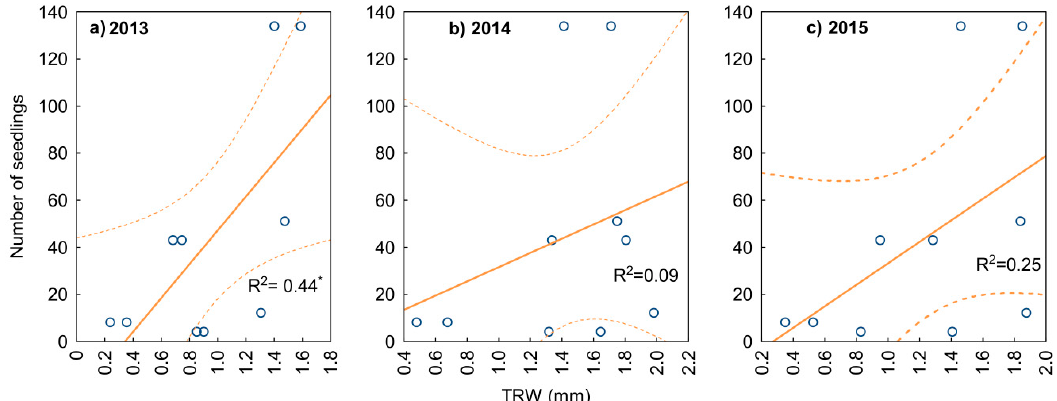
Figure 4. Relationship between density of yew seedlings and radial increment of mother trees in ( a ) the year prior to seed formation; ( b ) the year of seed formation; and ( c ) the year after seed formation. At the stand level, a significant increase in the tree-ring width of yews was observed after the beginning of stand regeneration via shelterwood cutting in 2000, for both males and females (Figure